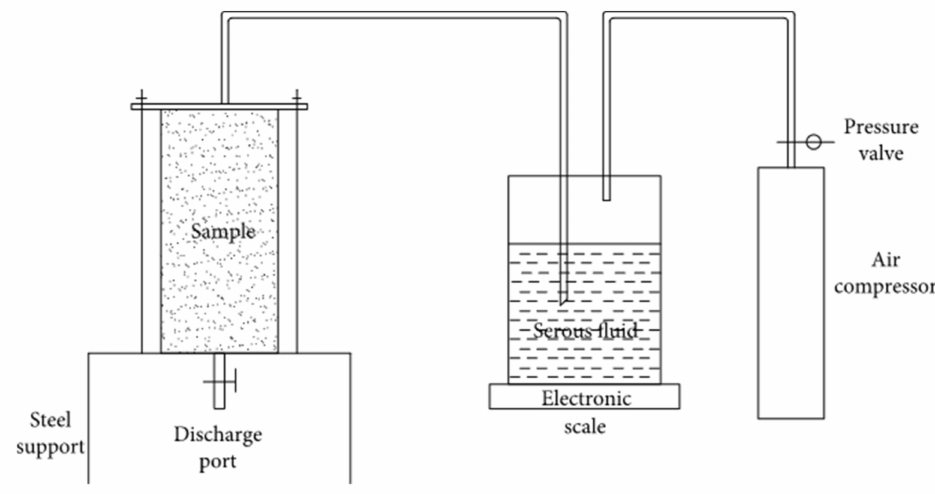
Figure 3. Schematic diagram of grouting consolidation device